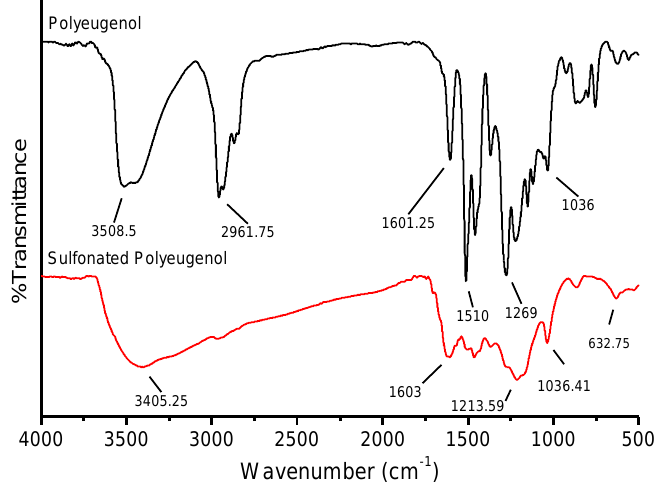
Figure 4. Graph of polyeugenol and sulfonated polyeugenol.